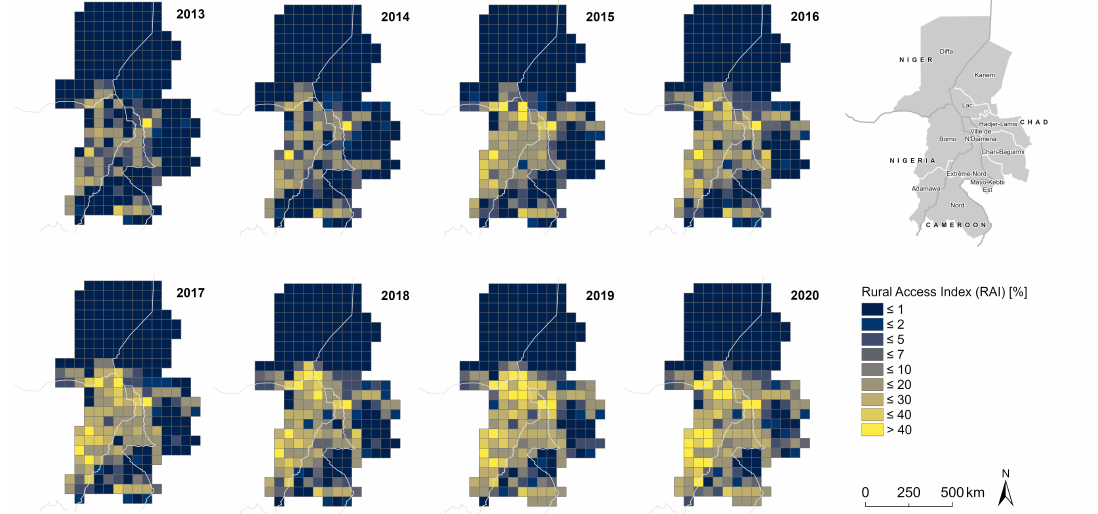
Figure 4. RAI between 2013 and 2020 on PRIO-GRID cell level (data source: Tollefsen et al., 2012,Global Administrative Areas,